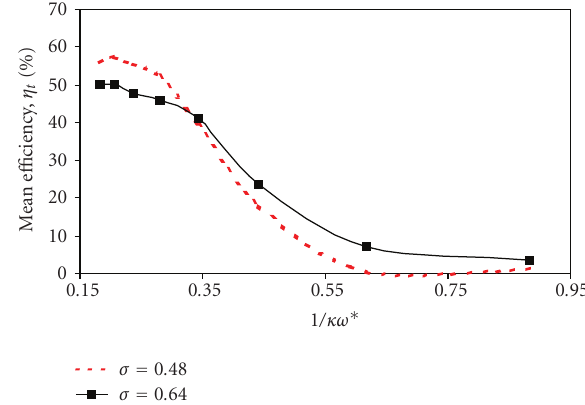
Figure 8: E ff ect of rotor solidity on the mean e ffi ciency of CA9 un- der real sea conditions (site2).